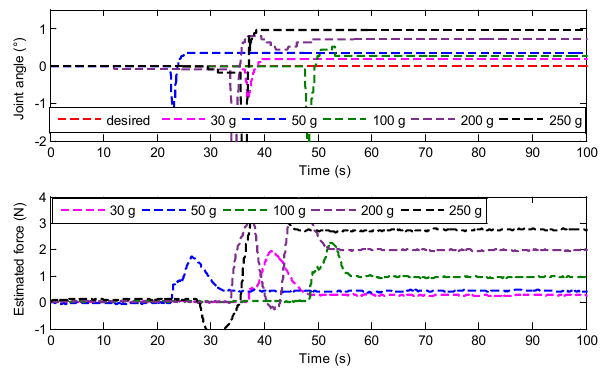
Figure 21. Positive direction loading experiment results at 0 ◦ . where x 1 is the position detected value of the grating ruler component 1, ¨ x 1 , ˙ x 1 and sgn( ˙ x 1 ) are acceleration, speed and symbolic function, respectively. The other models can sim- ilarly be written as expressions. The parameter matrixes of the three models can be obtained, and the identification re- sults and the identification errors are shown in Fig.